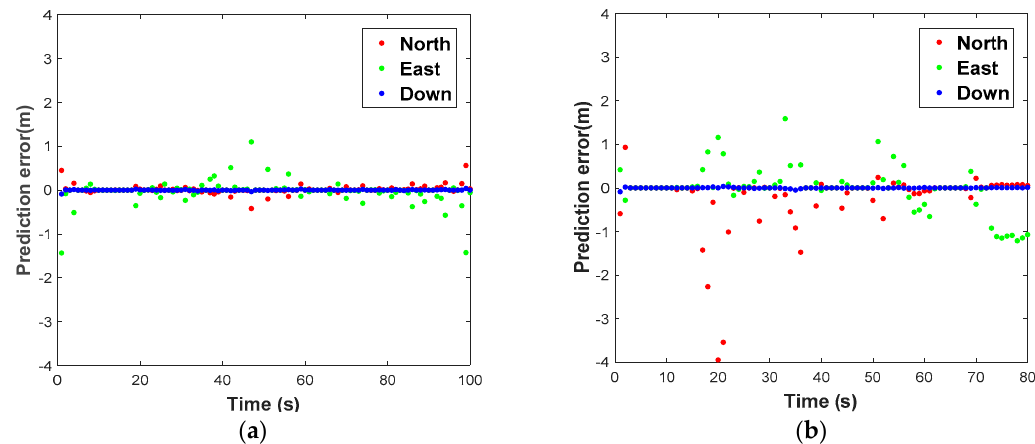
Figure 12. Prediction error with ORBF network algorithm in Test 1 ( a ) and Test 2 ( b ). Table 3. Prediction RMS and Failure rate.